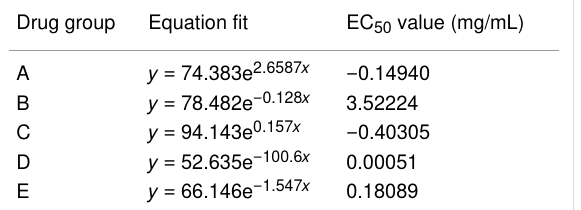
Table 4: EC 50 values of the various drug groups used in this in vitro study. Drug